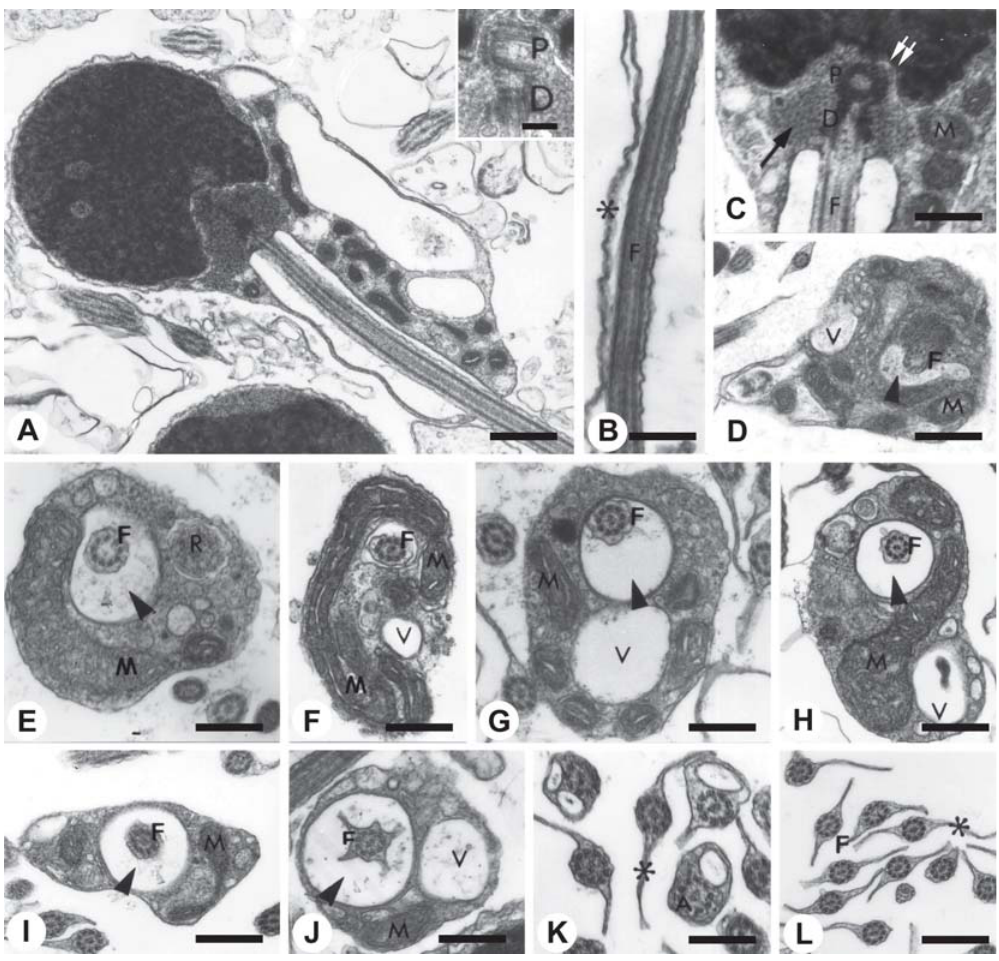
Fig. 3. Serrasalmus maculatus spermatozoa. A - Spermatozoa in longitudinal section. B - Flagellum in longitudinal section. C - Longitudinal section of the nucleus at the nuclear fossa region. D to J - Cross sections in different levels of midpiece. K and L - Flagella in cross sections. Note the vesicles in the initial segment of the flagella. Scale bars A = 0.5 µ m; A/Inset = 0.2 µ m; B- C = 0.45 µ m; D = 0.7 µ m; E and F = 0.4 µ m; G = 0.5 µ m; H and I = 0.55 µ m; J = 0.4 µ m; K = 0.35 µ m; L = 0.6 µ m. A: axoneme; C: centriole; D: distal centriole; F: flagellum; M: mitochondria; N: nucleus; P: proximal centriole; V: vesicle; Asterisk: fins; Arrow: electron dense material; Arrowhead: cytoplasmic canal; Double arrow: nuclear fossa; Star: cytoplasmic